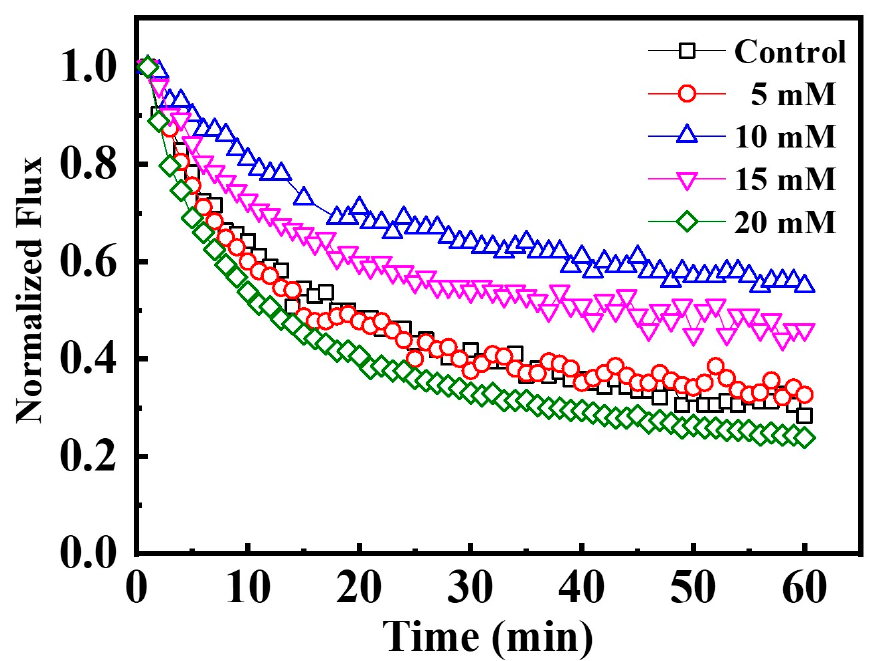
Figure 5. Anti-fouling performance as a function of ionic strength. Car-PES cathode and Ti anode: the 1 h normalized permeability vs. aqueous Na 2 SO 4 concentration; (conditions: (SA) in = 10 mg/L and (voltage) = − 1.0 V).